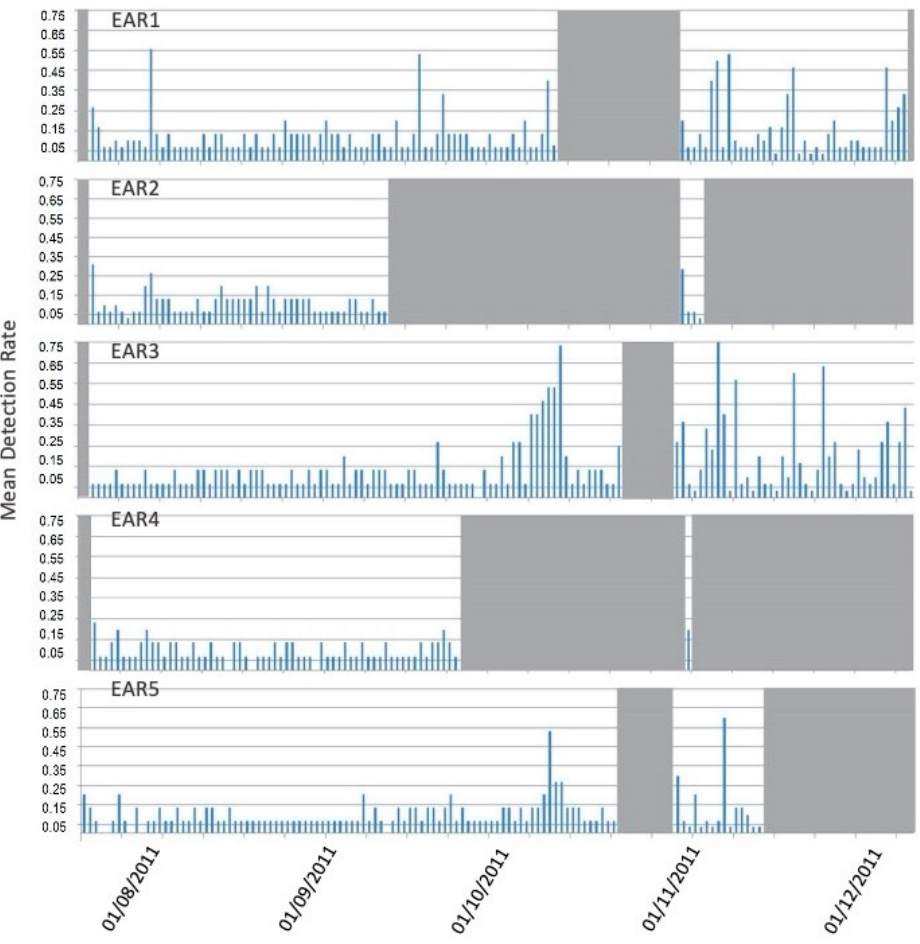
Figure 4. Mean hourly detection rate values (blue bars) at the five EARs during the recording periods. Gray boxes represent the periods with no recordings or when the hard drive (EAR2 and 5) or CF2 persistor (EAR 4) failed. Table 4. Statistically significant results of the Kruskall-Wallis and Tamhane tests carried out to analyze the monthly detection rate for each EAR. For the Tamhane test, the table shows only the statistically significant